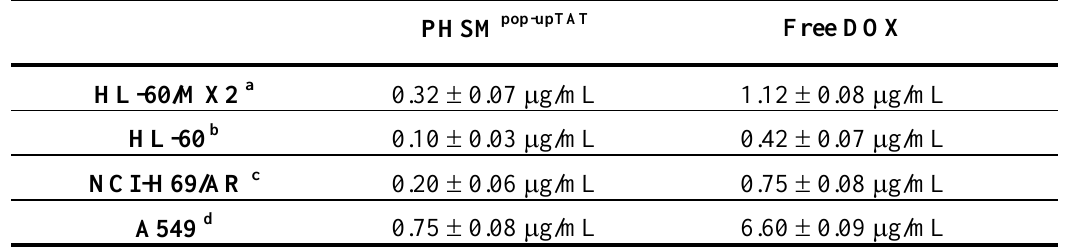
Table 2. IC50 of PHSM pop-upTAT and free DOX for human promyelocytic leukemia drug-resistant HL-60/MX2 (with decreased TopoII level), human promyelocytic leukemia HL-60 (with bcl -2), human lung drug-resistant NCI-H69/AR (with MRP), and human ovarian tumor A549 (with LRP) cells (n=9). All experiments were performed at pH 6.8 RPMI-1640/PBS medium. IC50 was obtained from the DOX concentration where 50% cell viability was achieved. Reproduced with permission from reference [73].